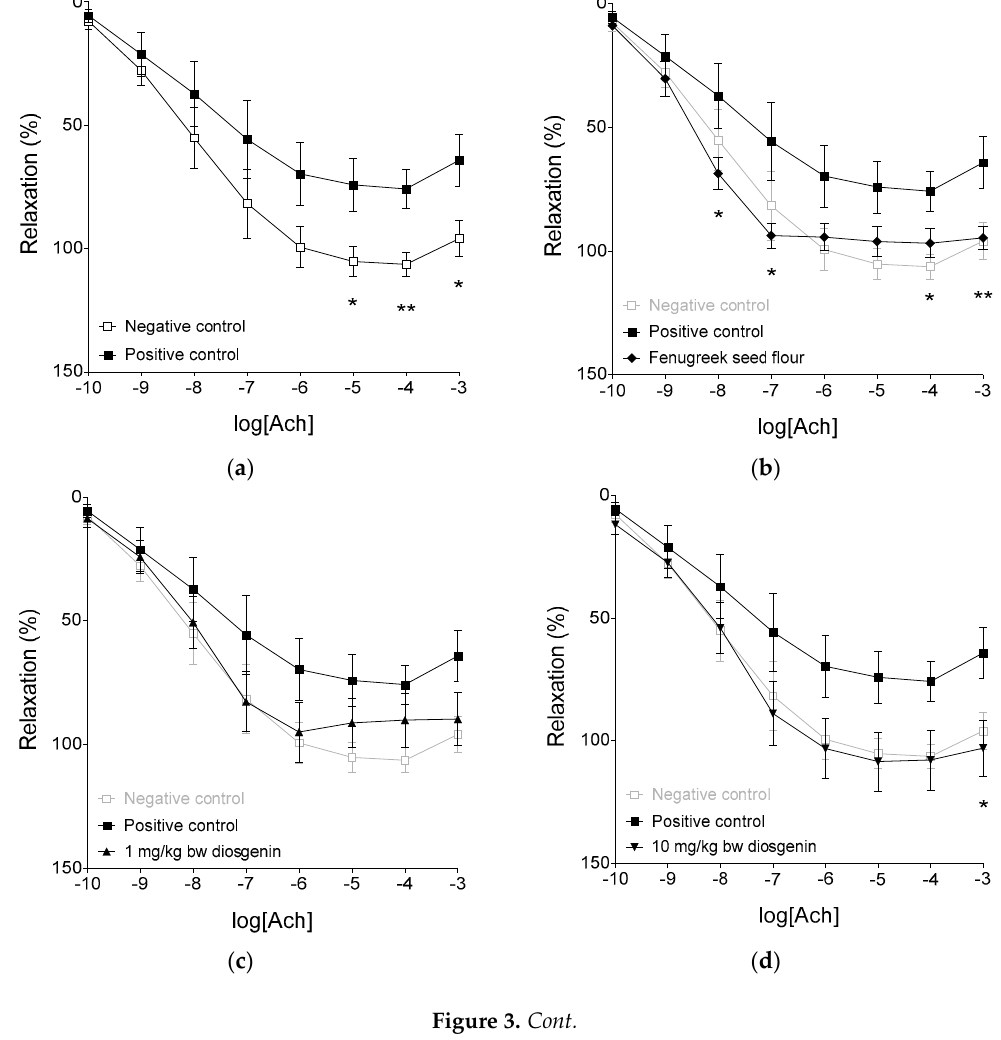
Figure 3. Cont. Figure 3.